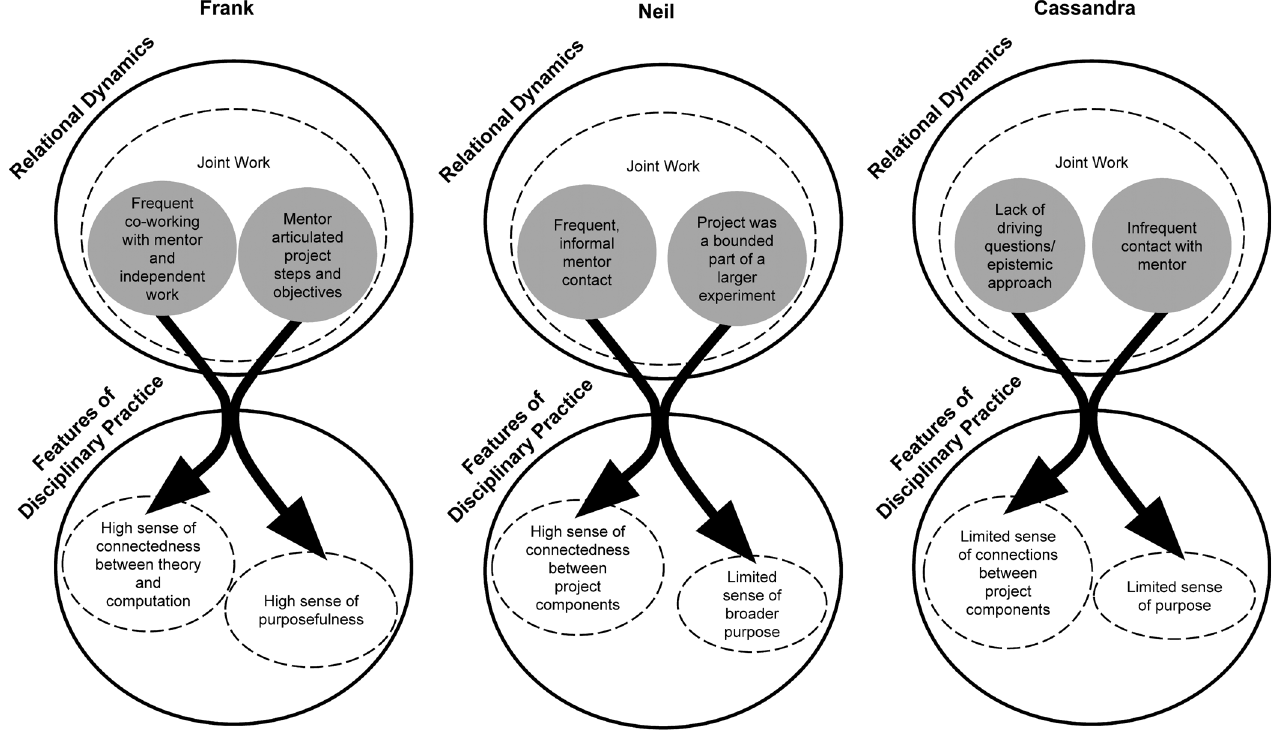
FIG. 2. Summary of connectedness, purposefulness, and joint work within the analytic